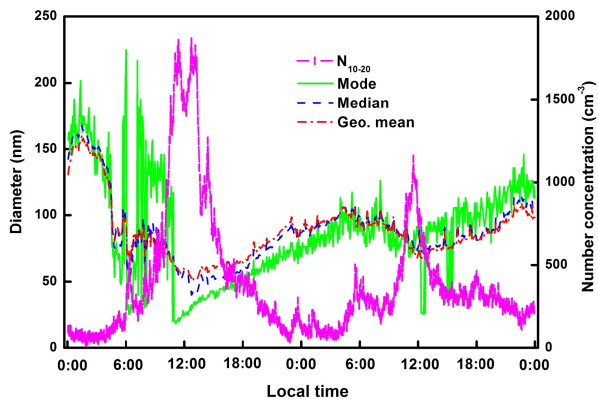
Figure 7. Temporal evolutions of 4min mean mode, median and diameters and 10–20nm particle concentration, showing the growth rate and formation of new particles on 3 and 4 April